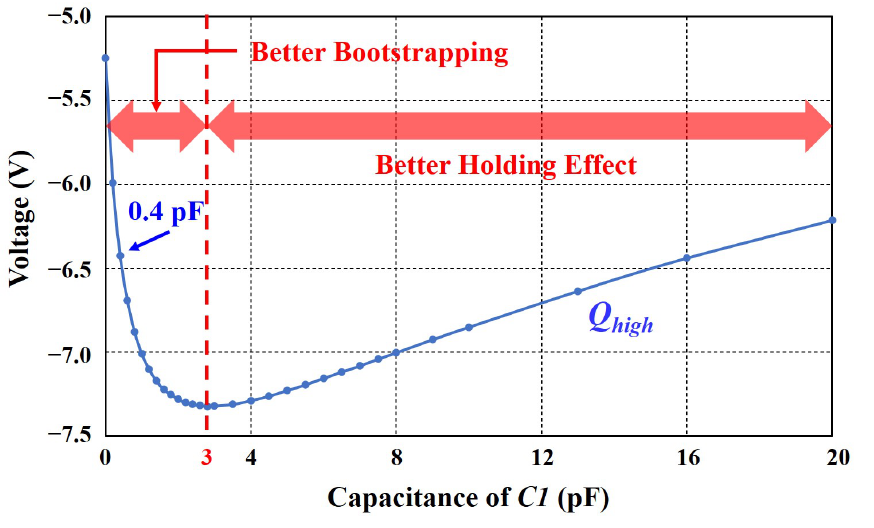
Figure 14. Plot of Q high versus the capacitance of C1